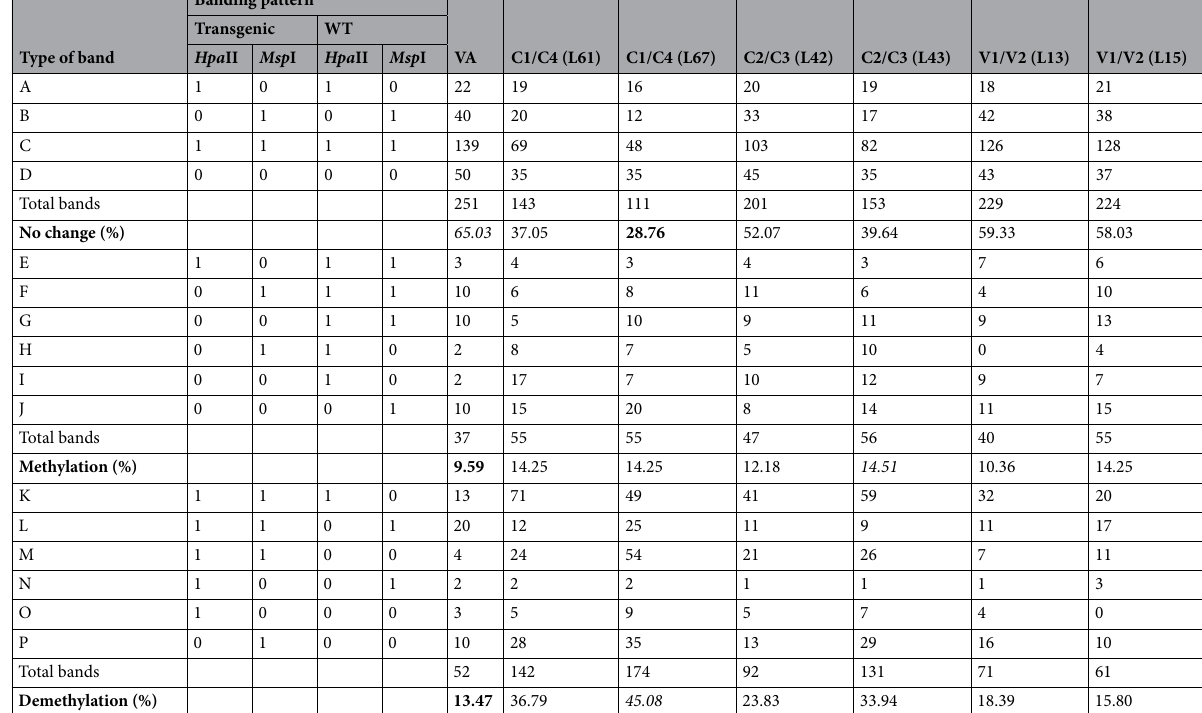
Table 3. The pairwise comparison of methylation and demethylation pattern of VA, C1/C4, C2/C3 and V1/V2 amiRNA transgenics with WT. The highest values indicated by italic and lowest values indicated by bold.